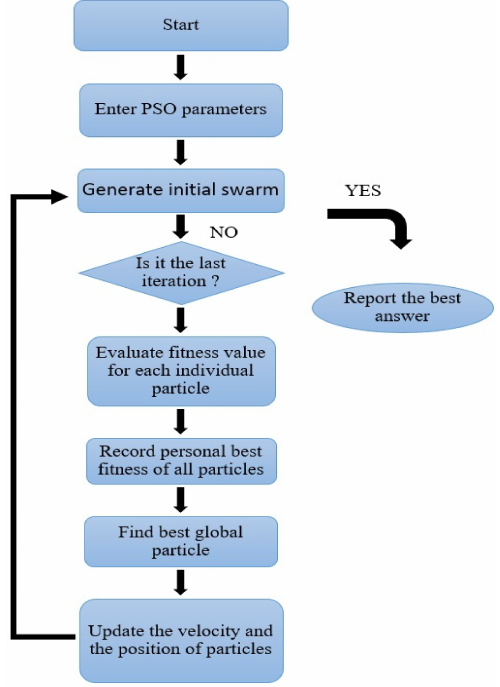
Figure 6. PSO sequential